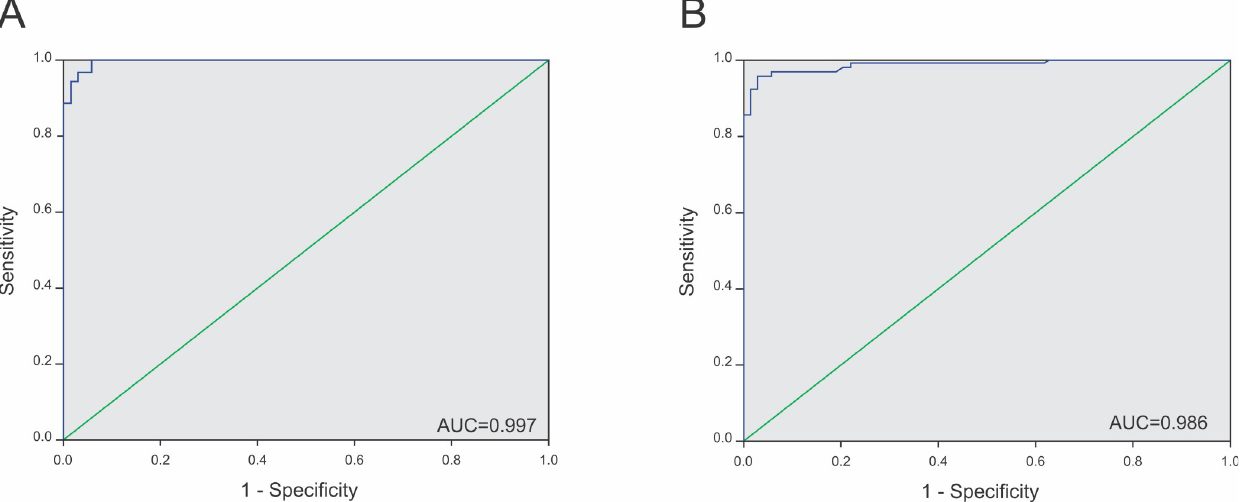
Fig 3. ROC curves constructed with the results of the positive and negative serum sample controls tested by the (A) LPG-ELISA or (B) TLA-ELISA. Overall, 97 positive and 68 negative controls were tested in each assay. The curves were made using SPSS v.12.0 software.